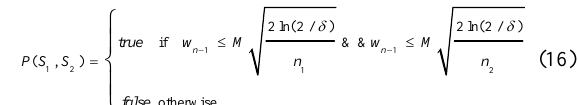
Fig.2 The relationship between the threshold and the area with different